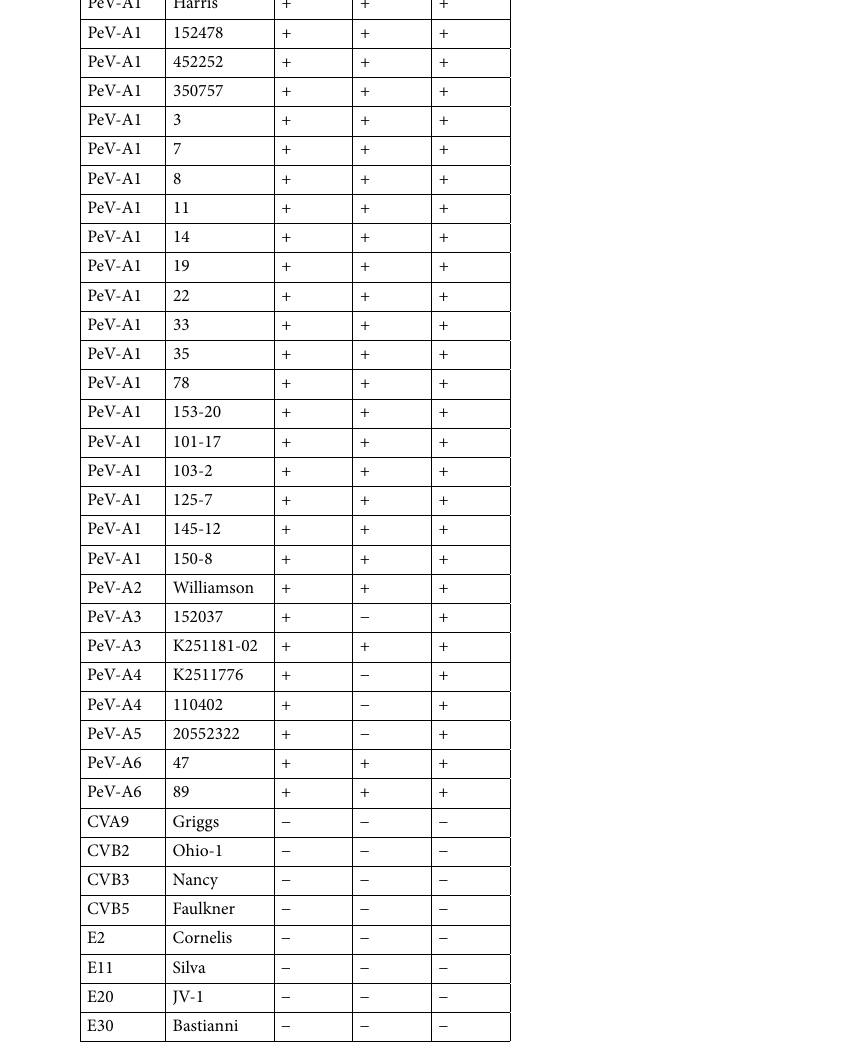
Table 2. Summary of the data from immunofluorescence microscopy